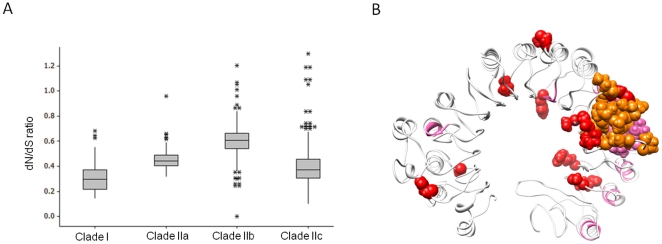
Selective pressures on the PRAME family.
A. The dN/dS ratio distributions in different clades. Clade I has the lowest mean and median dN/dS ratios. The vertical axis represents the dN/dS ratio. The asterisk (*) represents the outliers of the data. B. Map of the positively selected sites detected in Clade IIa to the PRAME protein model. The selected sites derived from PAML analyses are mapped to the protein homology model. Eight of the 12 selected sites (red) are clustered in the inner concave region of the protein model. The model was built based on the PRAME gene (GenBank acc. no. XM_001256020.1) on BTA16. The predicted DNA binding site is highlighted in orange. The LXXLL motifs are highlighted in pink.